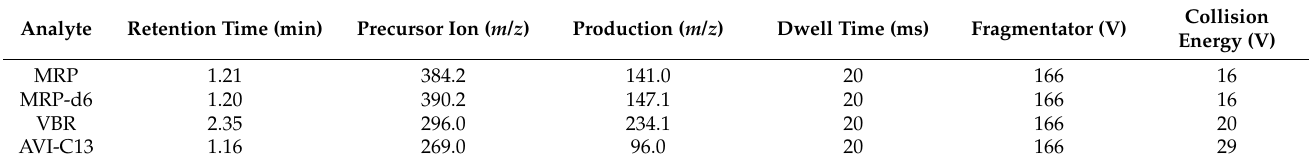
Table 1. Specific Multiple Reaction Monitoring (MRM) transition parameters used for MRP, MRP-d6 (IS), VBR, AVI-C13 (IS)